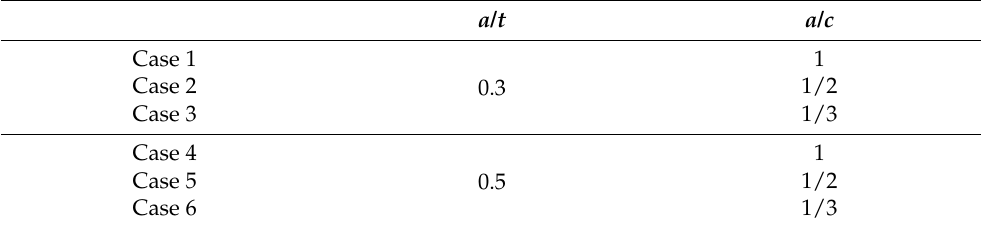
Table 5. Shape variables of the